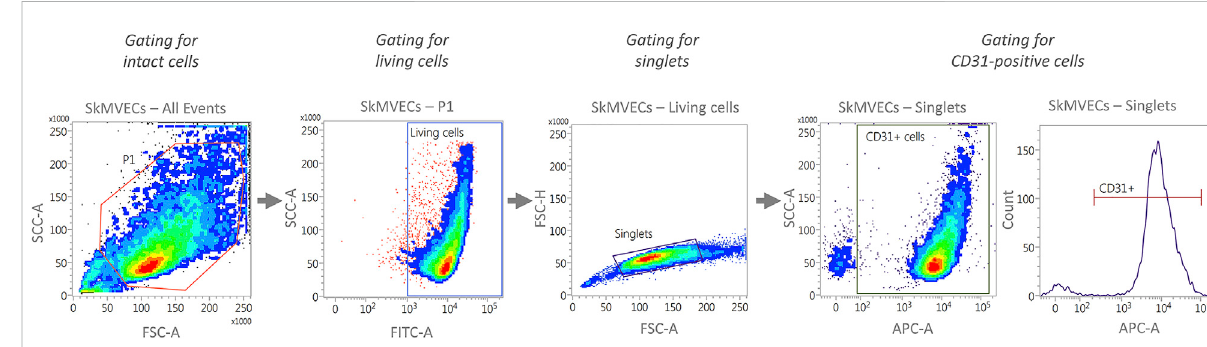
FIGURE 3 Representative plots generated by fl ow cytometry showing the recommended gating strategy for the characterization of isolated SkMVECs. First, intact cells are selected by plotting forward scatter area (FSC-A) versus side scatter area (SSC-A), with P1 representing the cell population excluding debris. Next, the cells are further gated for living cells by using FITC-channel for detecting Calcein AM labeled cells. Of the living cells, singlets are selected by plotting forward scatter height (FSC-H) versus forward scatter area (FSC-A). Finally, the singlets are further gated for APC-labeled CD31-positive cells using the APC